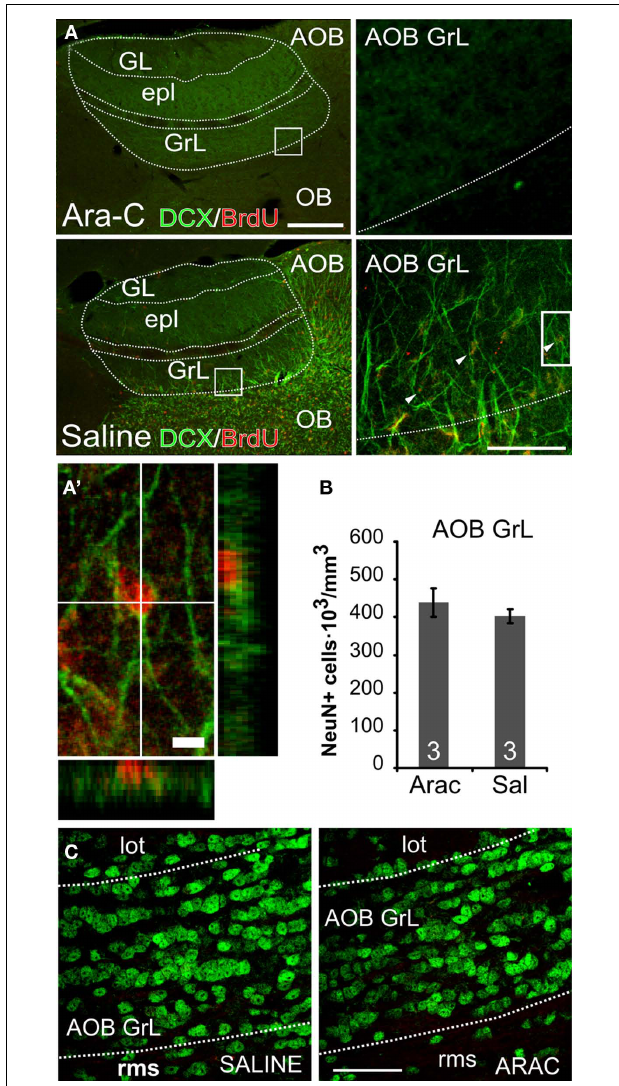
FIGURE 5 | Newborn but not pre-existingAOB–GrL interneurons are eliminated byAra-C treatment. (A) Micrographs showing double immunolabeling for doublecortin (DCX) and BrdU performed at the end of a saline or Ara-C (28days) infusion. Mice infused with Ara-C (upper panels) show a complete loss of immature neurons (DCX + , green staining) and newborn ones (BrdU + in red) contrarily to saline-treated animals [lower panels; newborn cells are indicated with arrowheads in the higher magnification panel on the right and in (A (cid:2) ) ; x:y:z = 1:1:4]. (B) , NeuN + cell density quantification in the granular layer of the AOB of saline and Ara-C treated mice. Data are means ± SEM ( n = 3 animals per group). (C) micrographs showing NeuN labeling in the AOB–GrL of Ara-C and saline-treated mice (lot, lateral olfactory tract; GrL, granular layer; rms, rostral migratory stream). Bars in (A) : left 200 μ m, middle 50 μ m, 5 μ m for the single cell magnification. In (C) : 50 μ m. Means ± SEM, the numbers in the graph bars indicate the amount of animals used.